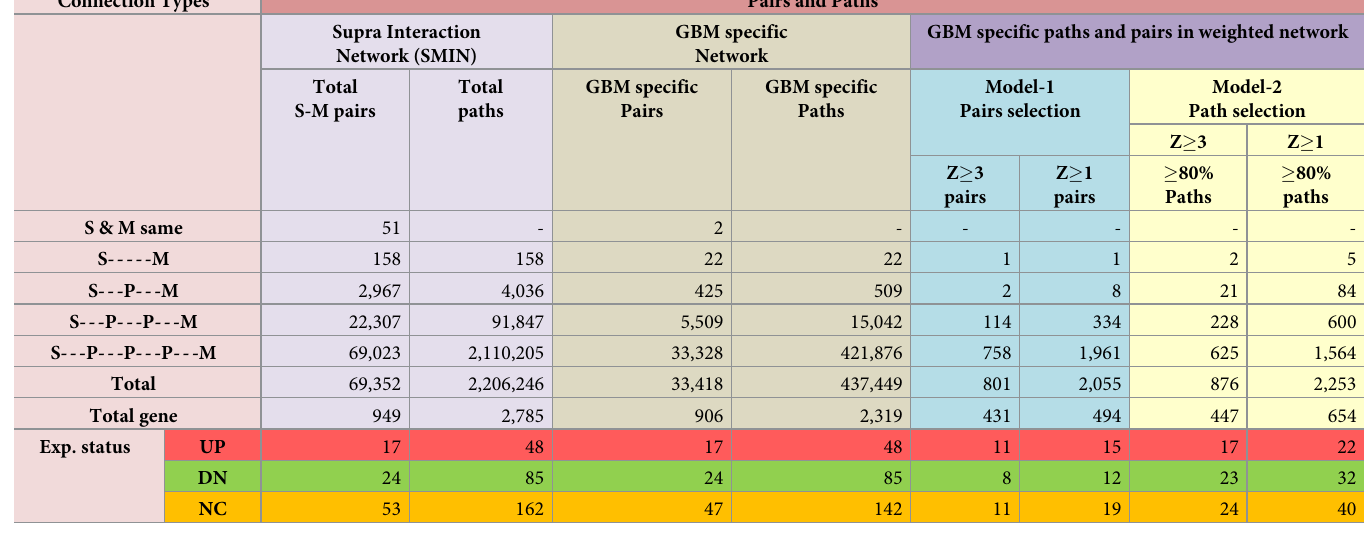
Table 1. Detailed statistics of paths, pairs, and proteins with expression involved in stepwise filtration of the signaling-metabolic interaction network (SMIN) to the significant GBM-specific network with the differential expression states in the EGFR-mutated cell line U87MGvIII compared to U87MG with wild-type EGFR. Connection